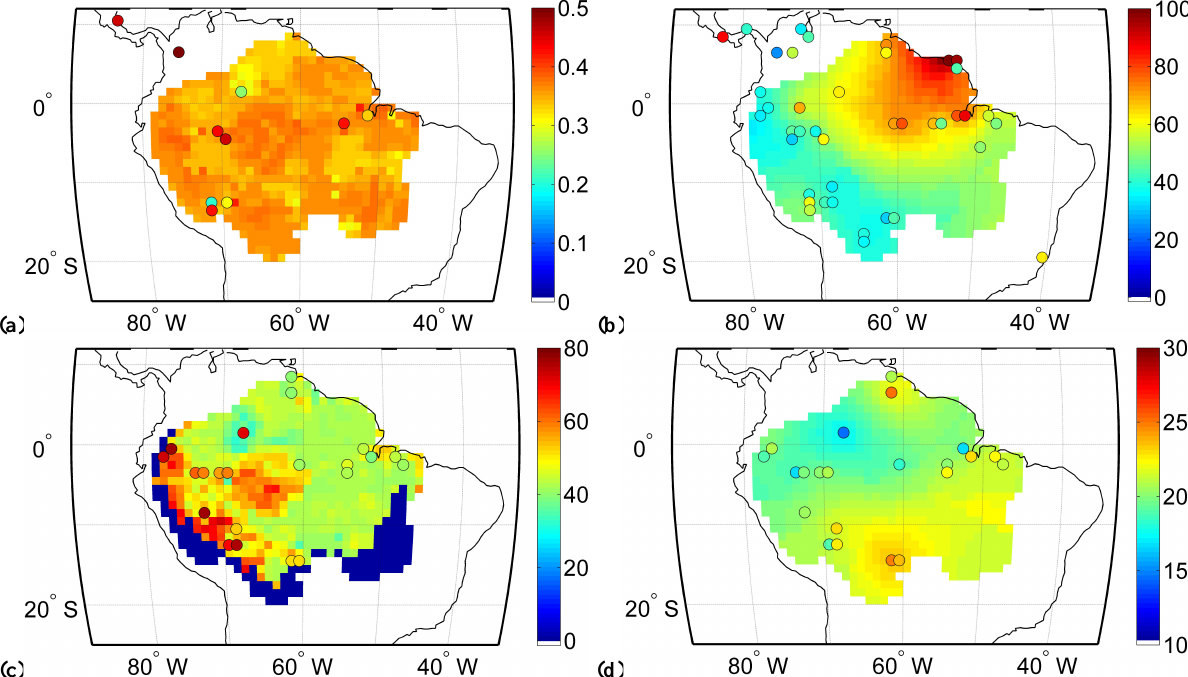
Fig. 5. Site-specific field data (dots) and the extrapolated map (background): (a) carbon allocation to wood [fraction], where the extrapolated map is based on sand fraction map; (b) woody biomass residence time [years], where the extrapolation is by kriging interpolation of site